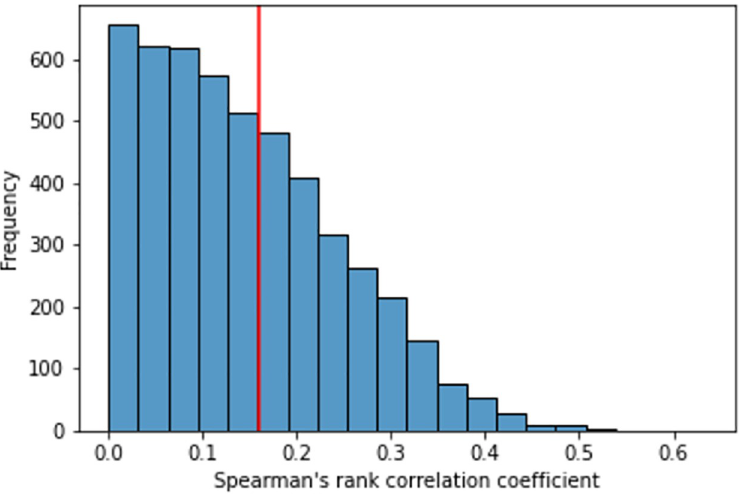
Fig 7. Histogram of frequency of Spearman correlation values between pairs of events M